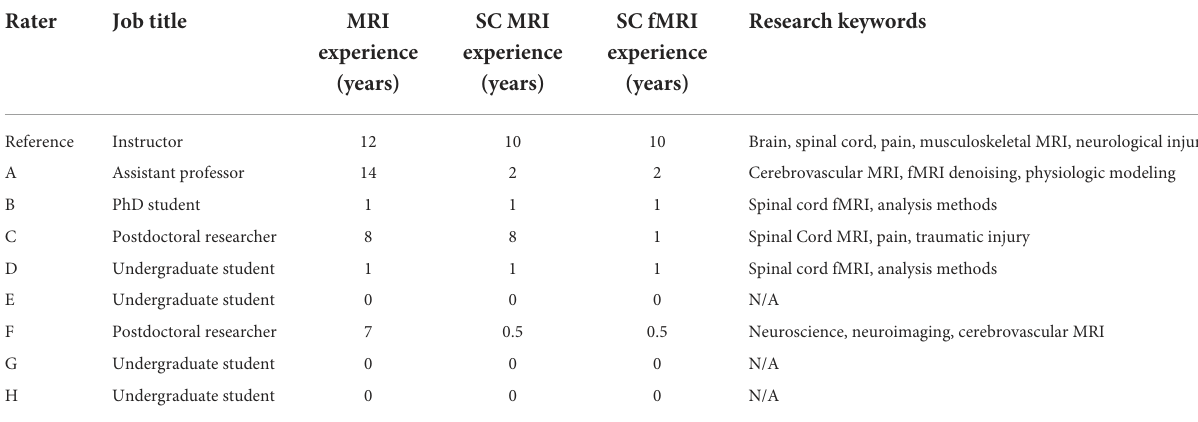
TABLE 1 Description of each rater’s background.